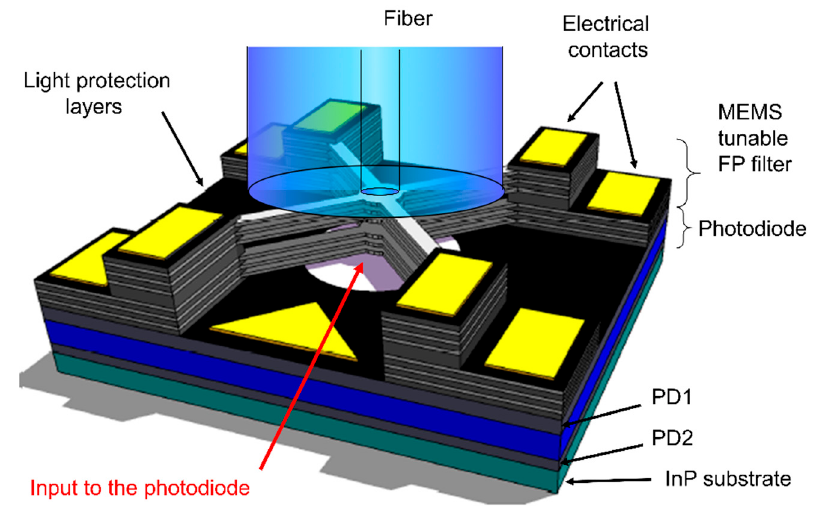
Figure 16. Interferometric sensor for the NIR spectral range, consisting of a MEMS tunable filter and a photodiode. The actuation voltage will be applied between the rectangular and triangular contact pads. The photodiode is biased via the two highly doped semiconductor layers PD1 and PD4, and the sensor signal is also picked off between PD1 (triangular contact pad) and PD4 (substrate con- tact). To allow light incidence only on the white area, the rest of the PD top is covered by light protection layers. The rectangular contact pads correspond to the round contact pads in Figures 13 and 15, as well as to the rectangular contact pads in Figure 14. The InP material system enabling monolithic integration with InGaAs photodiodes is not only beneficial for NIR sensorics, but also very favorable for receiver systems to be used for NIR wavelengths tailored for telecommunication requirements of low fiber dis- persion and low fiber absorption. Our lab demonstrator including MEMS tunable FP fil- ters and InGaAs photodiodes in monolithic integration was working well in the labora- tory practice. In addition, a packaged MEMS tunable filter with two fiber pigtails was demonstrated using the InP/multiple air-gap material system. 10. Limits of Semiconductor and Dielectric Material Systems for MEMS-Based Sensorics: Geometry, FWHM, Tuning and Stopband Width In this section, further conceptional facts and details are presented as a continuation to Sections 8 and 9. A separate Section 10 was chosen for this purpose to avoid overloading and interruption of the common thought in the previous two sections. The first question is, how do the membranes of the top and bottom DBR move under electrostatic actuation? Figure 17a shows the InP multiple air-gap FP filter without applied voltage (unactuated), and Figure 17b displays the real situation when an actuation voltage is applied (actuated state). Because of applied voltage, charges are shifted. The charges accumulate mainly at the inner surfaces of the two central membranes. Therefore, the two central membranes are mainly actuated. Consequently, the outer membranes stay nearly uncharged and remain nearly unactuated. The outer membranes remain nearly unaf- fected due to shielding effects. Figure 17c displays a hypothetic situation, in which all the membranes of the top DBR are actuated in the same way and the whole bottom DBR moves in unity.